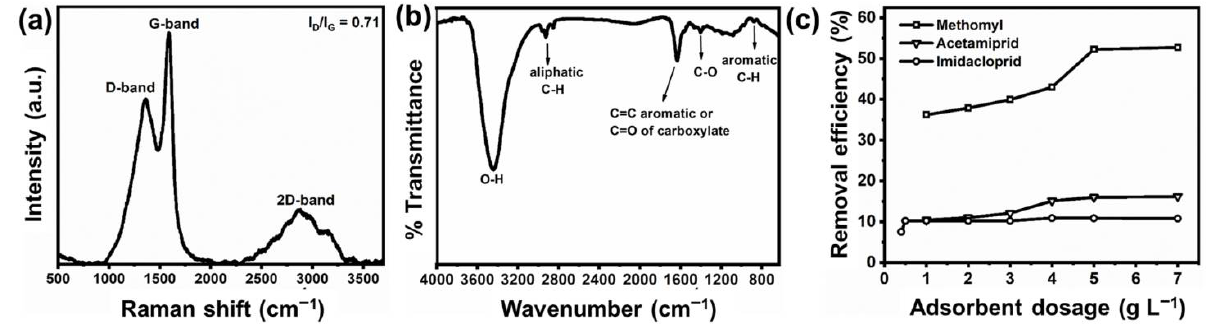
Figure 2. ( a ) Raman, ( b ) FTIR spectra of the BC. The D and G band in the Raman spectrum correlate to graphitic structures and defected graphitic structures, respectively, and ( c ) effect of adsorbent dosage on removal efficiencies of pesticides in an aqueous media (Conditions: 100 mL of aqueous solution of pesticide, pH = 7, 25 °C, 6 h).